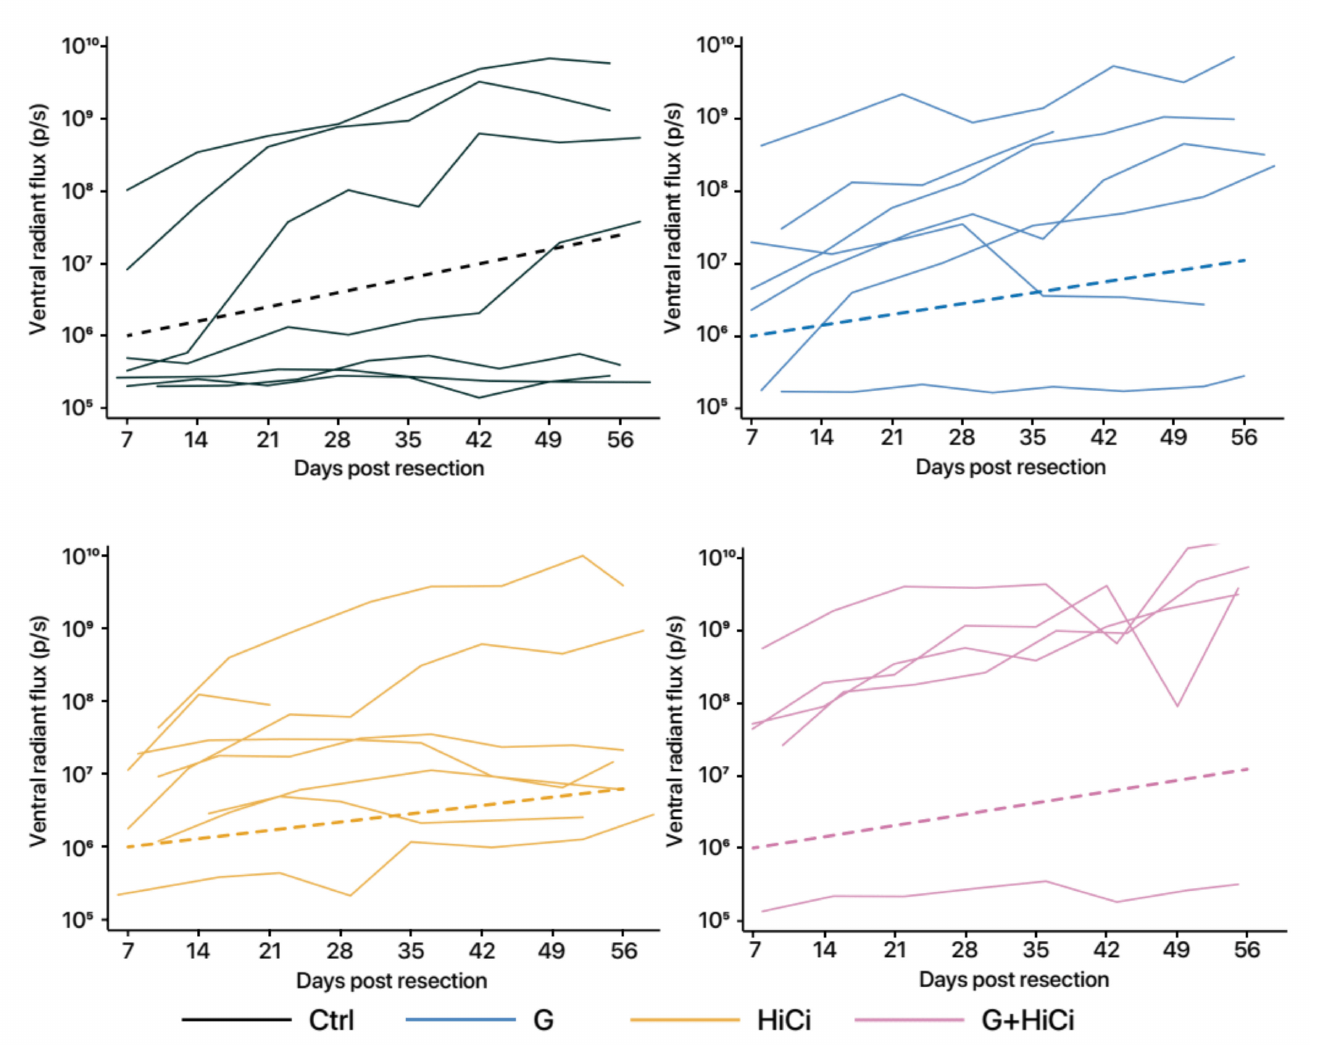
Figure A6. Spaghetti plot demonstrating the trajectories of tumour burden over time in the subgroup of mice with recurrent disease. The solid lines represent the actual trajectories, while the dotted line represents the predicted trajectory for a mouse with an low residual disease post resection (initial flux of 10 6 p/s) for a given treatment group. This predicted trajectory is based on the statistical model tabulated in Table A4 and illustrated in Figure 1c. Note that the ventral radiant flux, a surrogate measure of total disease burden, is in logarithmic scale. Therefore, a linear trajectory represents exponential tumour growth, and each unit represents a 10 × increase in radiant flux, thus a small change in the gradient of the curve represents a significant change in the progression of disease of a mouse. Note also that the gradient of the trajectories increases as the initial radiant flux increases, which is reflected in statistical model. While high levels of residual disease post resection results in rapid progression of disease in all groups, in the HiCi group, mild to moderate disease burden resulted in a relatively flat trajectory, reflecting the significant treatment effect found in the statistical